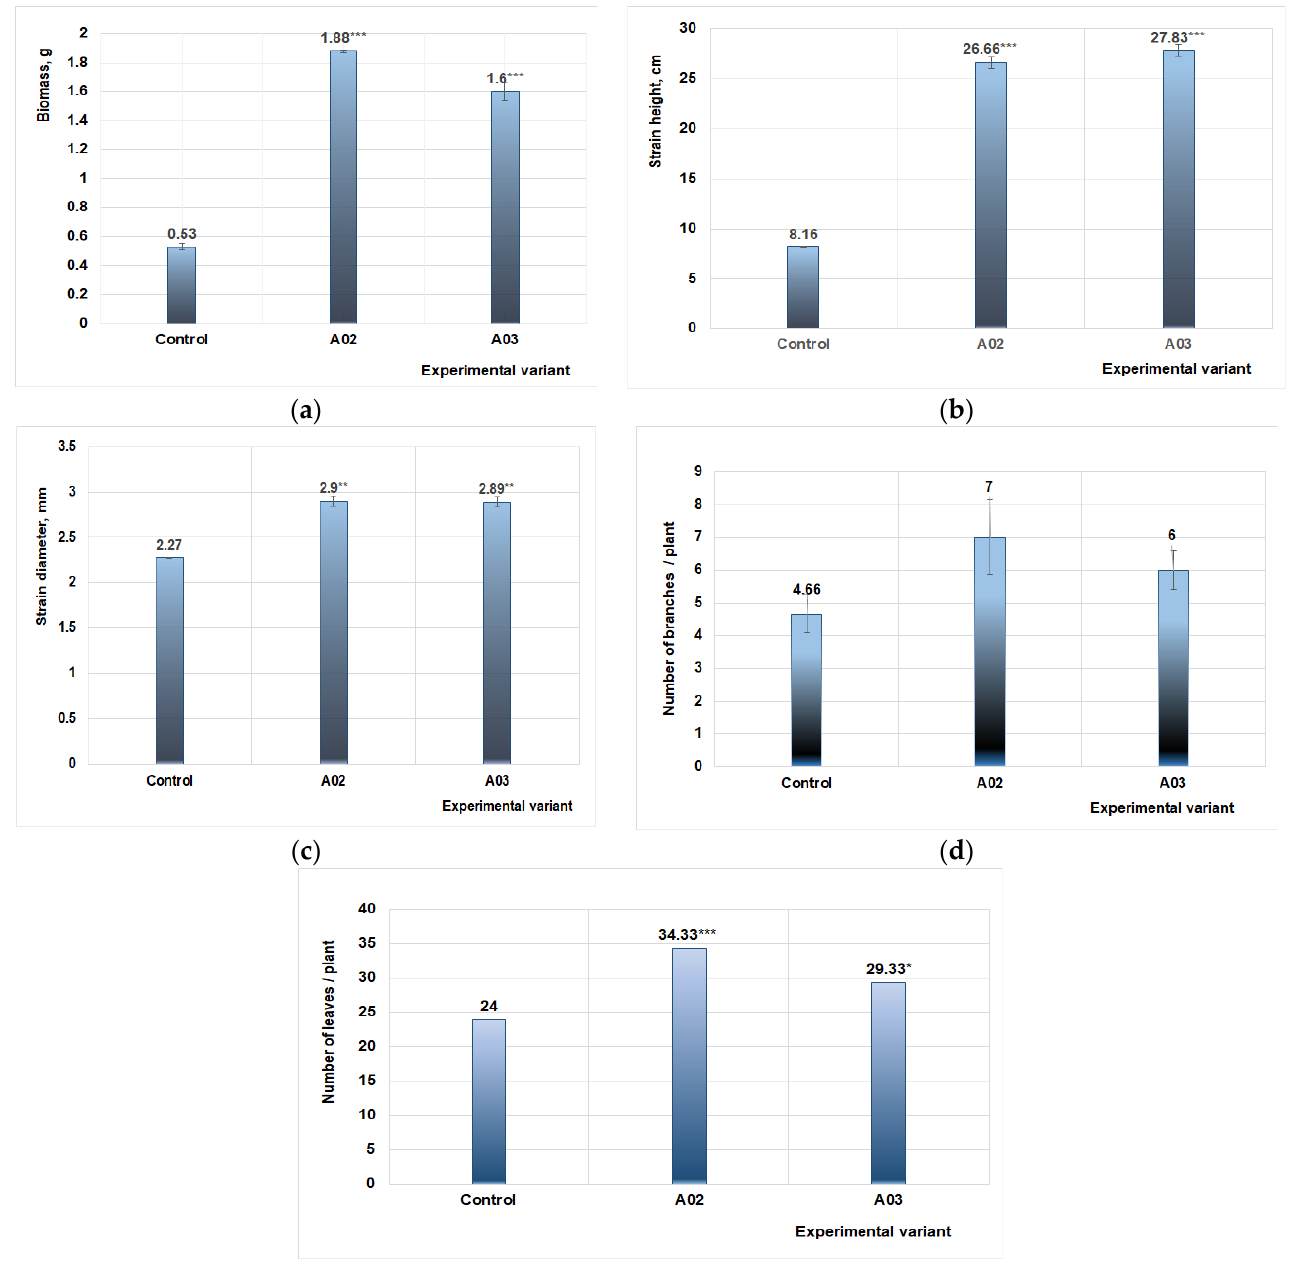
Figure 7. The influence on tomato plants of treatments with PH obtained from Paecilomyces lilacinus cultured on keratin medium. ( a ) Influence on production of biomass (average values). ( b ) Influence on plant height (average values). ( c ) Influence on plant diameter (average values). ( d ) Influence on number of branches per plant (average values). ( e ) Influence on number of plants leaves (average values). Experimental variants: control (A01) — data of plant treated with water; A02 — data of plant treated with PH from P. lilacinus cultured on feather medium; A03 — data of plant treated with PH from P. lilacinus cultured on wool medium.